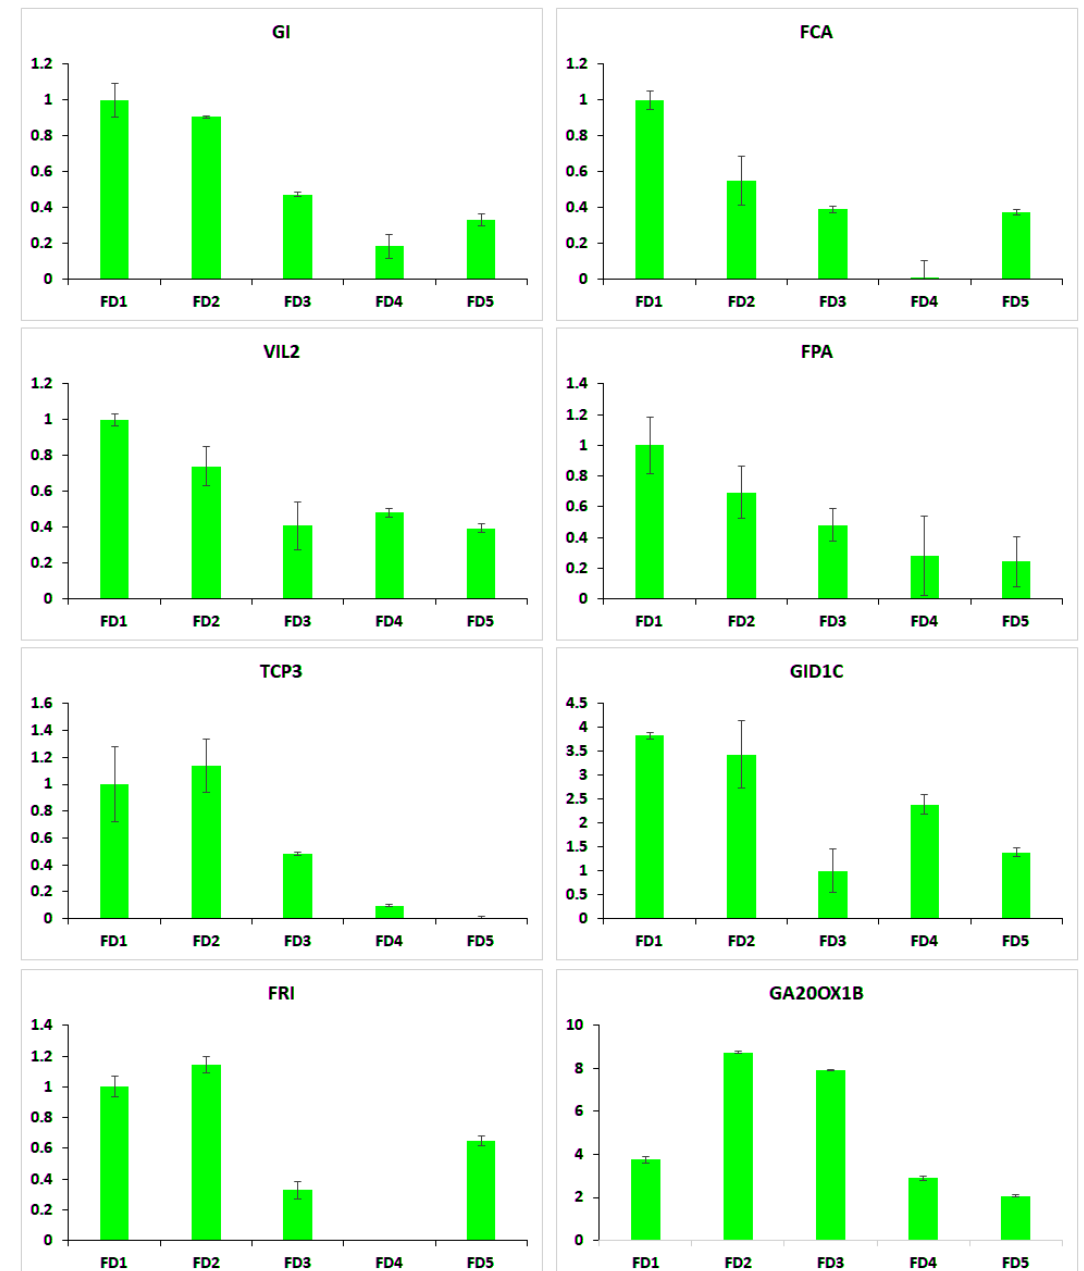
Figure 5. The qRT-PCR analysis of selected candidate mRNAs.